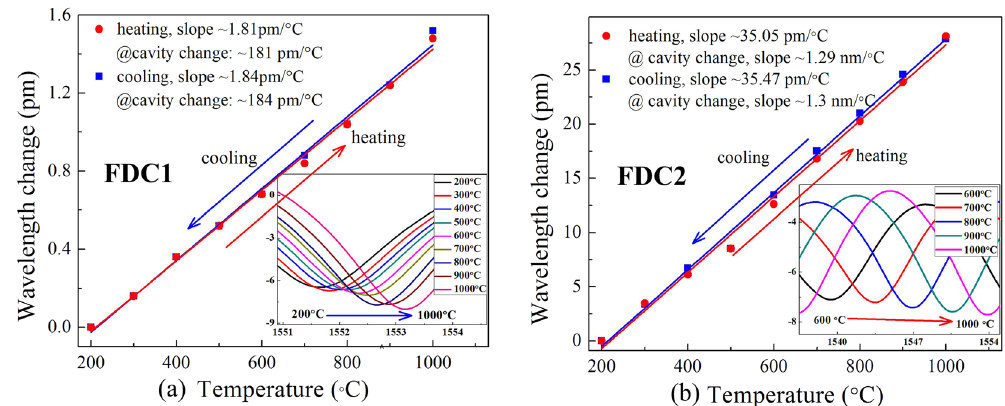
Figure 6. High temperature response of samples from room temperature to 1000 °C. As shown in ( a , b ), the corresponding to cavity change sensitivity, i.e. FDC1 and FDC2, are about 184 and 1300 pm/°C. The inset presents the reflection spectral evolution versus ambient temperature around 1550